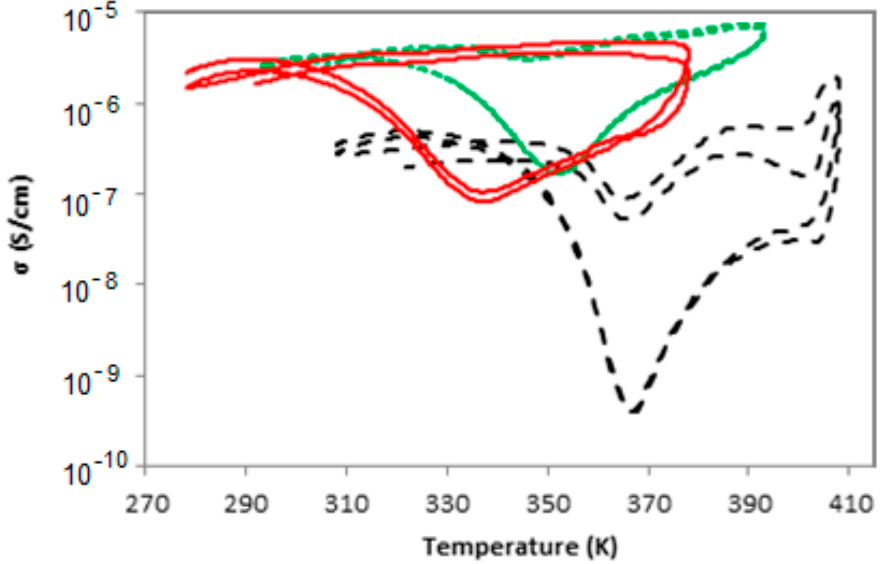
Figure 10. Thermal cycling of EVAs with 4.5 vol% GNP and increasing VA content: 9% (dashed black line), 20% (dotted green line) and 33% (continuous red line). Notice the shift of the conductivity minimum to a lower temperature with increasing VA content.